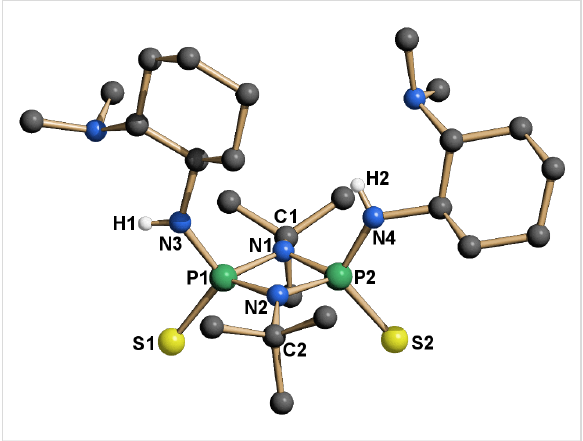
Figure 7: X-ray structure of 15 . The hydrogen atoms are omitted for clarity, except at nitrogen.